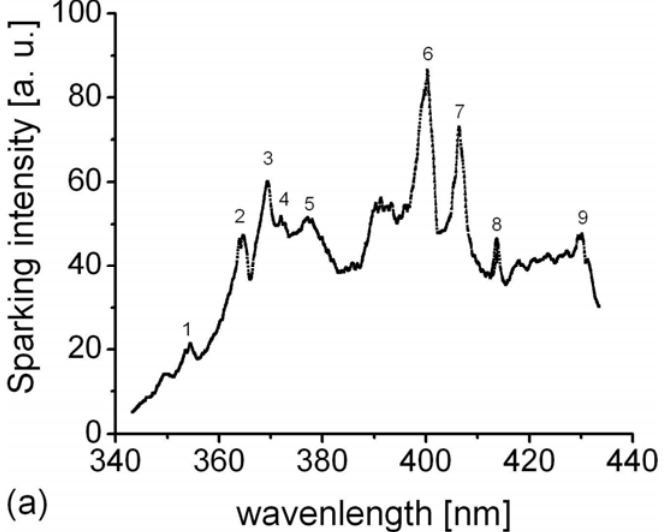
Figure 8. Luminescence spectra recorded during MAO in the spectral range: (a) 340 nm – 440 nm; (b) 520 nm – 560